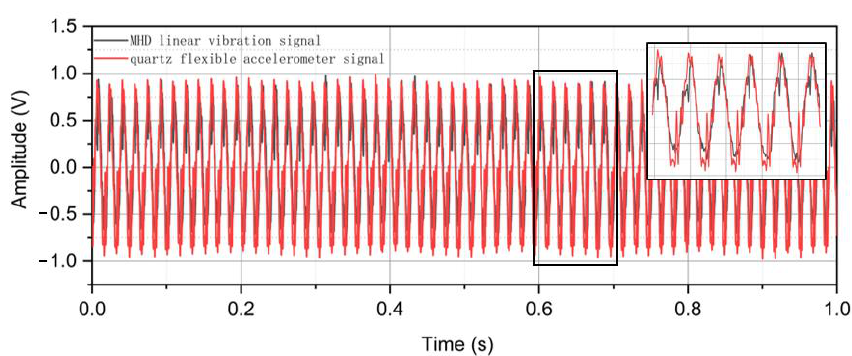
Figure 8. Comparison of output signals of quartz flexible accelerometer and linear vibration signals of MHD after SSA-FastICA processing.